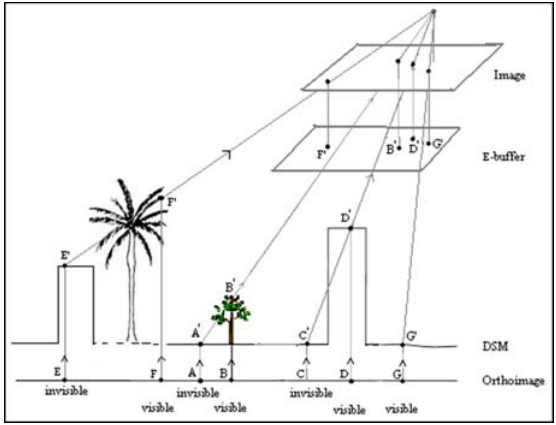
Figure 3. Visibility analysis based on